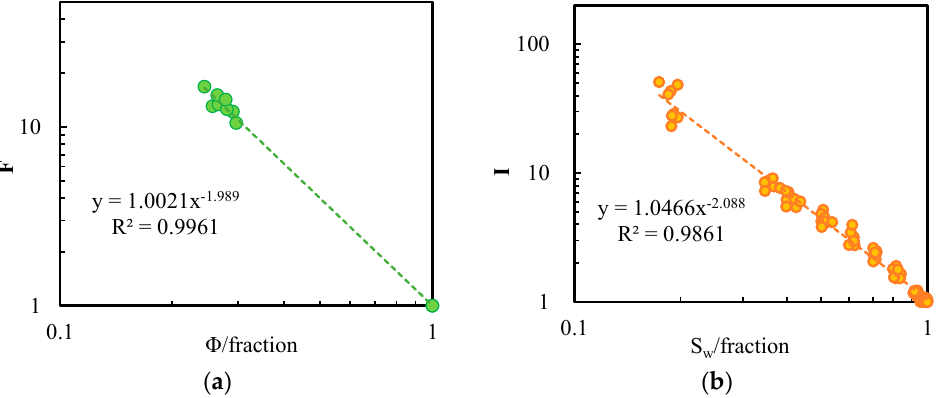
Figure 3. Relationship between formation factor ( F ) and porosity ( Φ ) and between resistivity index ( I ) and water saturation ( S w ) of core samples of the mudstone biogas reservoir. ( a ) F - Φ . ( b ) I - S w .